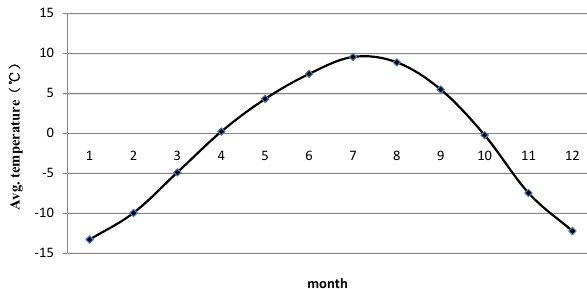
Fig. 4. Average monthly temperature of headwaters region of the Yellow